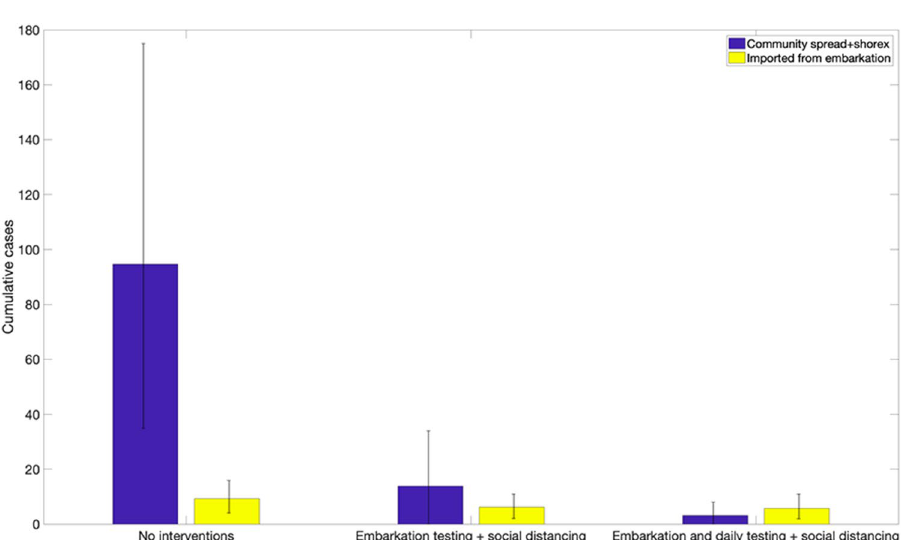
Figure 5. Distribution of the cumulative number of infections during 7-day cruises for three different scenarios using the baseline parameter values displayed in Table 1. The error bars reflect the 95% CI of the outcome distribution from 200 stochastic